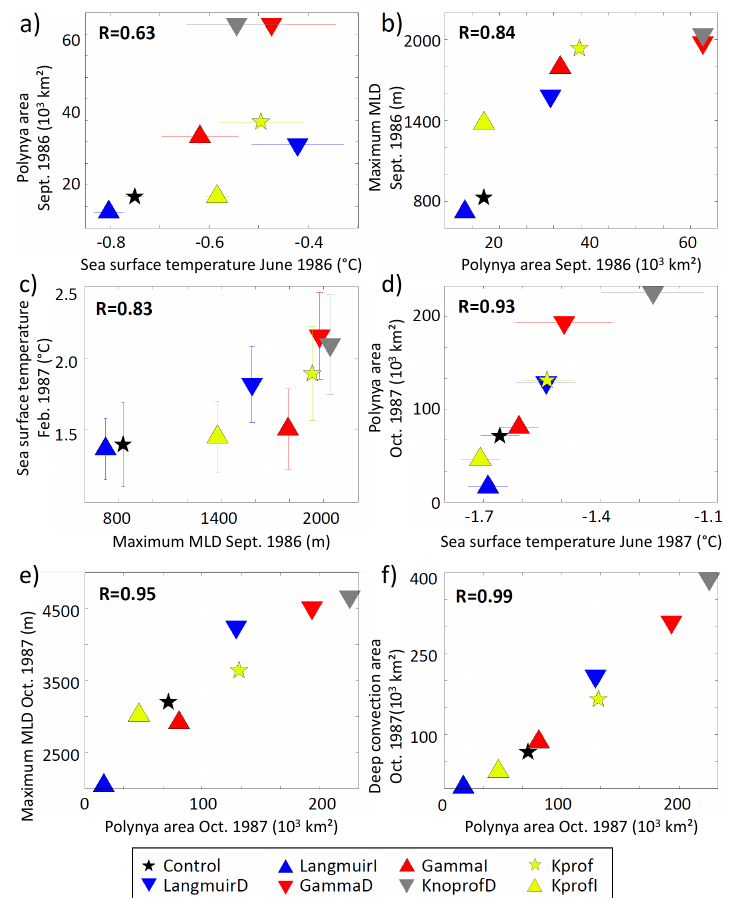
Figure 4. Across-run significant relationships between the steps leading to the deep convection event of the winter of 1987. (a) Sea sur- face temperature in June 1986 and polynya area in September 1986; (b) polynya area and maximum depth of the mixed layer, both in September 1986; (c) maximum depth of the mixed layer in September 1986 and sea surface temperature in February 1987; (d) sea surface temperature in June 1987 and polynya area in October 1987; (e) polynya area and maximum depth of the mixed layer, both in October 1987; (f) polynya area and deep convection area, both in October 1987. Horizontal bars on (a) and (d) and vertical bars on (c) indicate the standard deviation relative to spatial